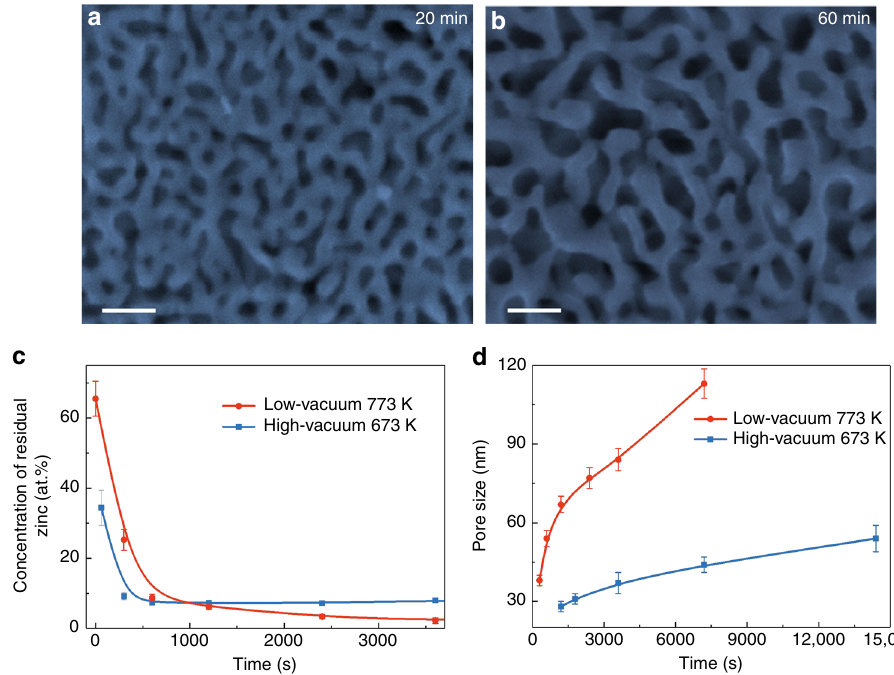
Fig. 3 Microstructural characterization of nanoporous cobalt under high-vacuum. a , b SEM images of nanoporous cobalt with dealloying time of 20 and 60 min at 673 K and 6 × 10 − 3 Pa. a , b Scale bars, 100 nm. c The relation between the concentration of residual zinc and dealloying time for both low- and high- vacuum dealloying conditions. d Correlation between pore size and dealloying time for different dealloying